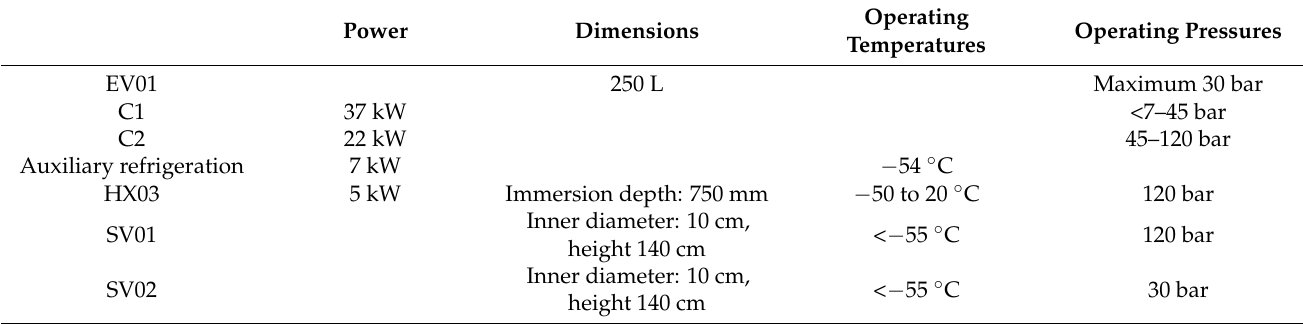
Table 1. Relevant characteristics for a selection of the components in the process.